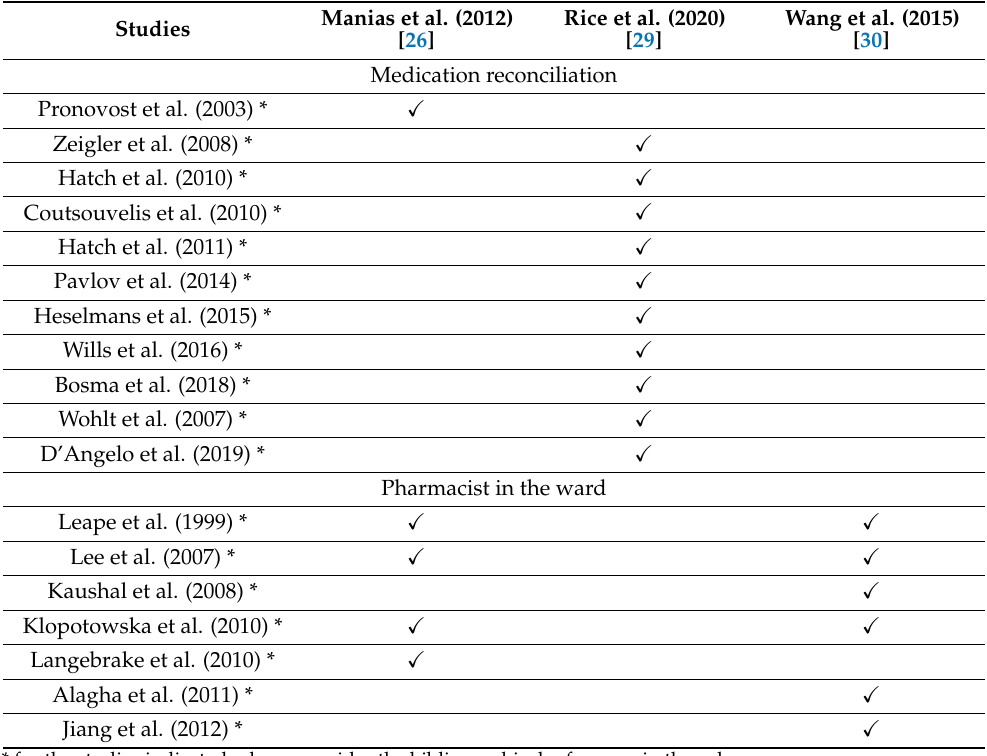
Table 5. Studies on interventions to prevent errors during medication reconciliation included in the systematic reviews included.